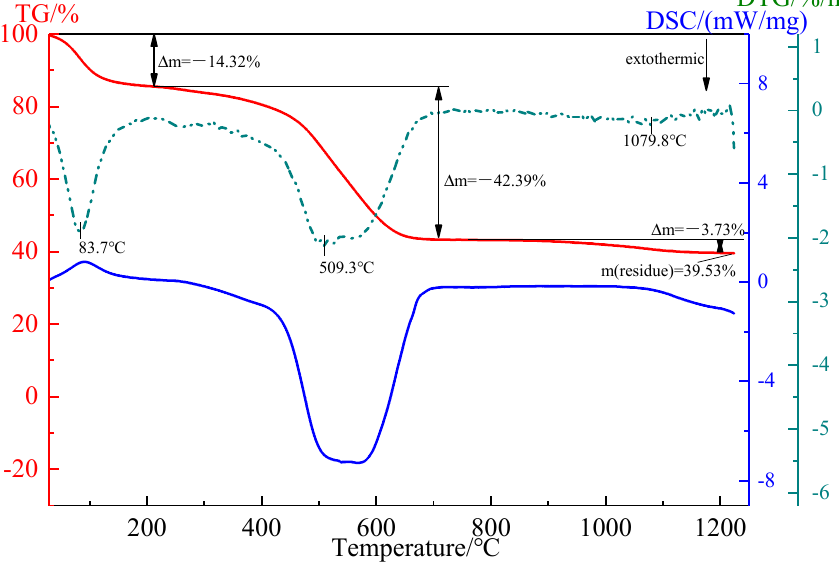
Figure 3. TG-DSC curves of humic substance-based binder.